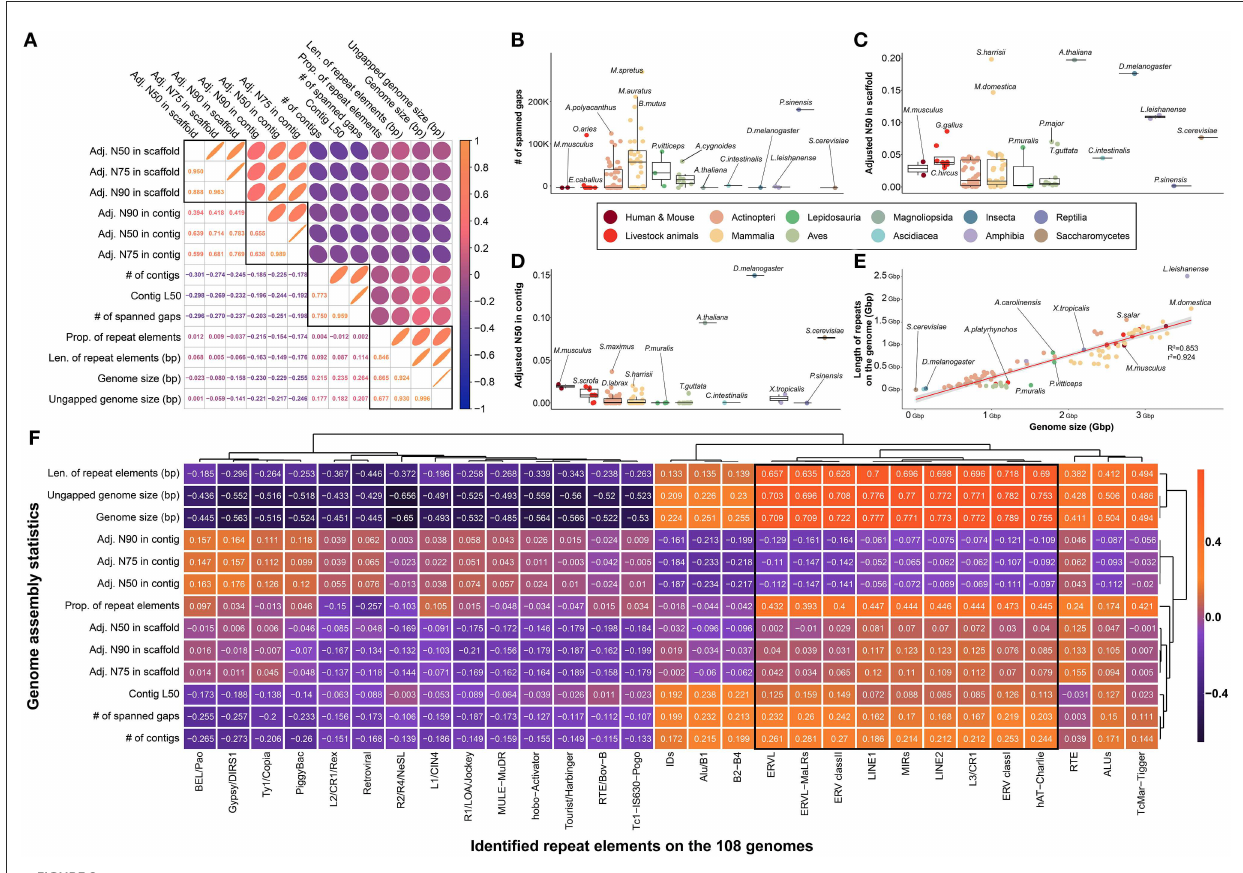
FIGURE2 Comparison of assembly statistics for selection of effective indicators for genome quality evaluation of various species relatively. (A) Investigation of correlation between various assembly statistics and repeat elements that are presumed to be related to genome quality evaluation. Pearson’s correlation coefficients were used to pairwise investigation. Four major types of indicators showed strong correlations. (B) The number of spanned gaps remaining in the genomes of 109 species. (C) Comparison of adjusted N50 in scaffold level by genome size. (D) Comparison of adjusted N50 in contig level by genome size. (E) Strong correlation between genome size and total length of repeat elements in each species. R 2 and r 2 represents coefficient of determination and correlation coefficient, respectively. (F) Correlation between the assembly statistics and the amount of various types of repeat elements found in the genome of 108 species. (B–E) The colors in the figure share group information separated by class taxonomic level, except for human-mouse and eight livestock